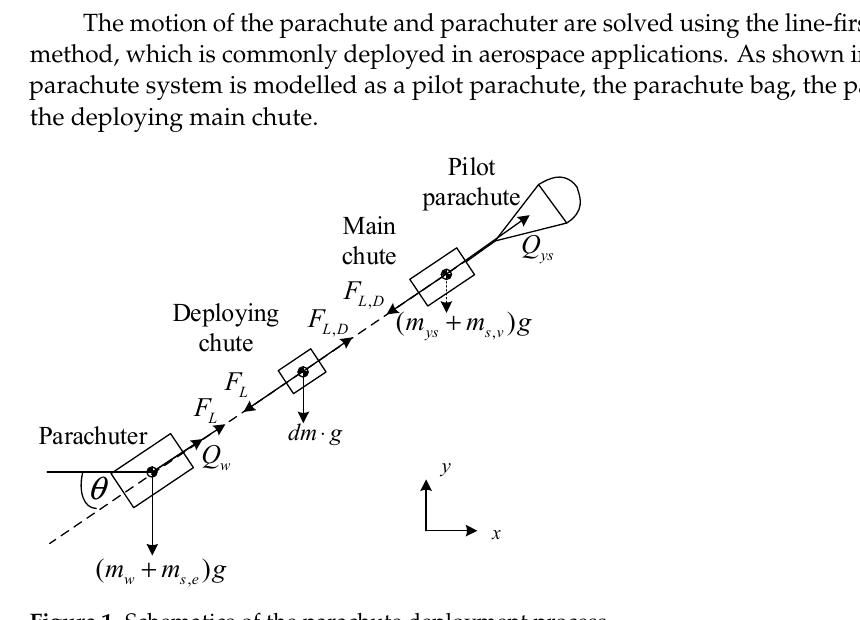
Figure 1. Schematics of the parachute deployment process.